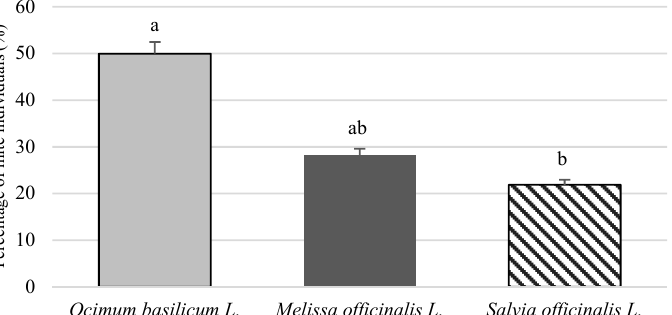
Figure 1. Level of Ocimum basilicum , Melisa officinalis and Salvia officinalis acceptance after 24 h of T. urticae infestation. Bars marked by different letters are significantly different at p ≤ 0.05 (Kruskal– Wallis’ test).